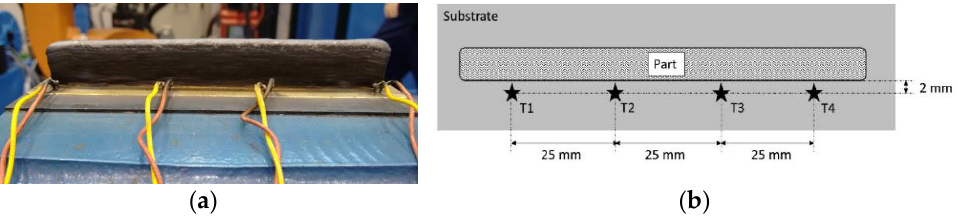
Figure 5. ( a ) Thermocouples attached to the substrate for temperature recording during the manu- facturing of the walls and ( b ) a schema of their position in the substrate. T1: thermocouple 1, T2: thermocouple 2, T3: thermocouple 3, T4: thermocouple 4. In order to verify the absence of defects inside the manufactured walls, non-destructive